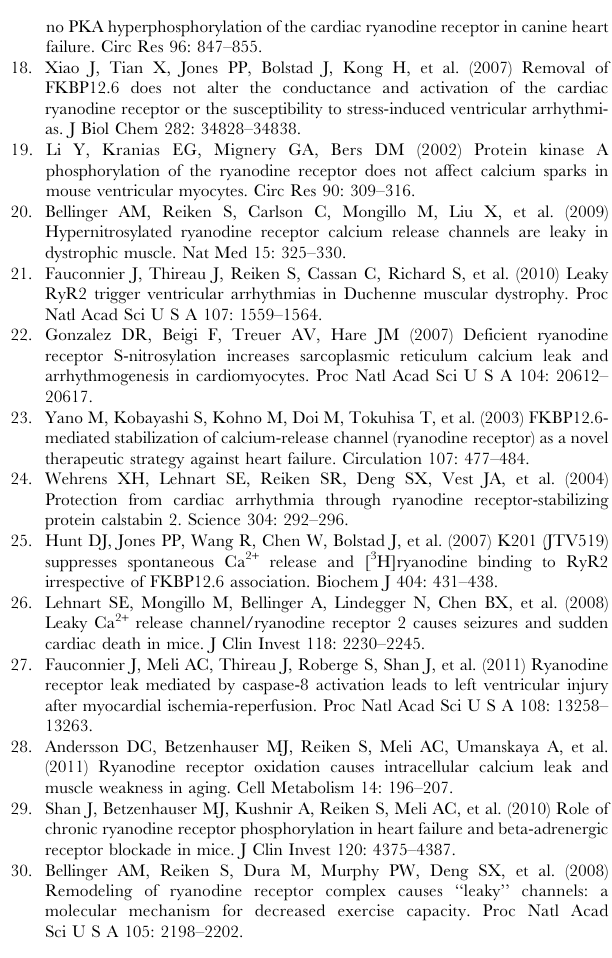
Figure S5 Single channel measurements with NOC12- treated RyR1s. (A) FK506-treated SR vesicles were